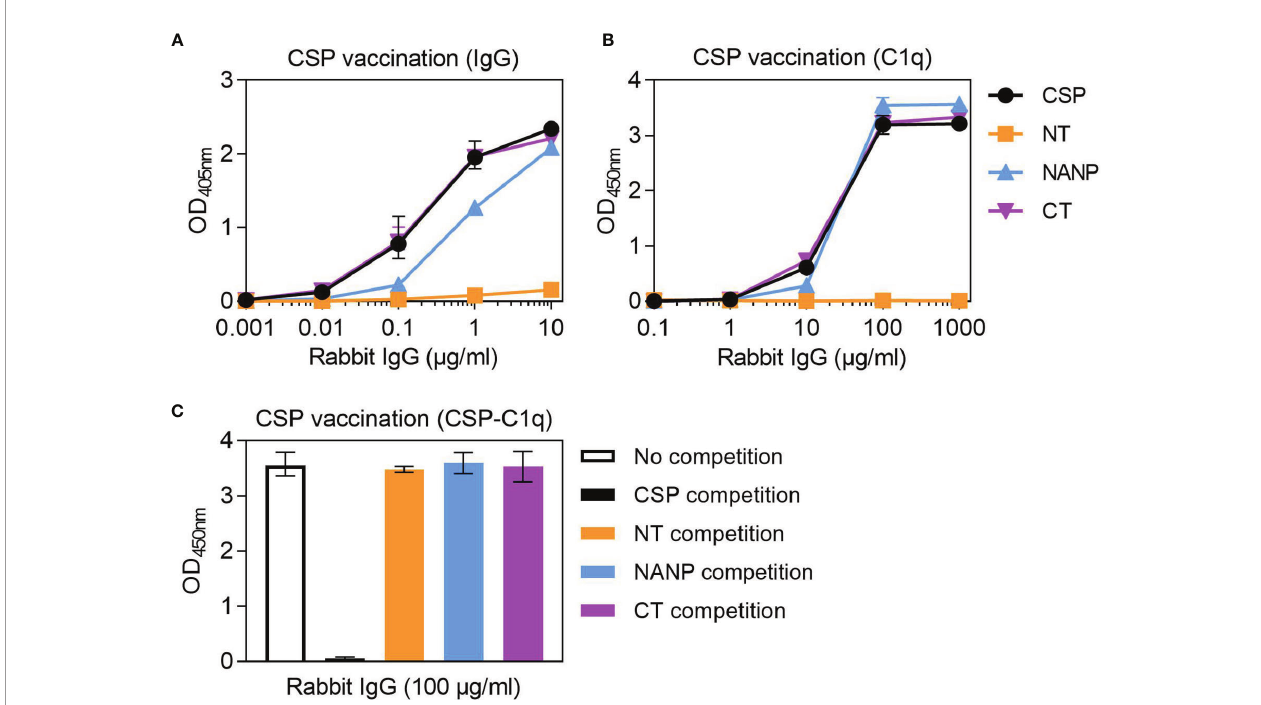
FIGURE 4 | Complement- fi xing activity of rabbit anti-CSP IgG to different regions of CSP. Rabbit anti-CSP IgG was tested for (A) IgG at 0.001-10 m g/ml and (B) C1q- fi xation at 0.1-1000 m g/ml to CSP and antigens representing the N-terminal (NT), central-repeat (NANP) and C-terminal (CT) regions of CSP; x-axis was presented on a log10 scale. (C) The rabbit anti-CSP IgG was also tested at 100 m g/ml for C1q- fi xation to CSP after pre-incubation with competing anitgen (including a no competition control); see Figure S1B for related data. Results were corrected for background reactivity using no-IgG control wells and the mean and range of two independent experiments is